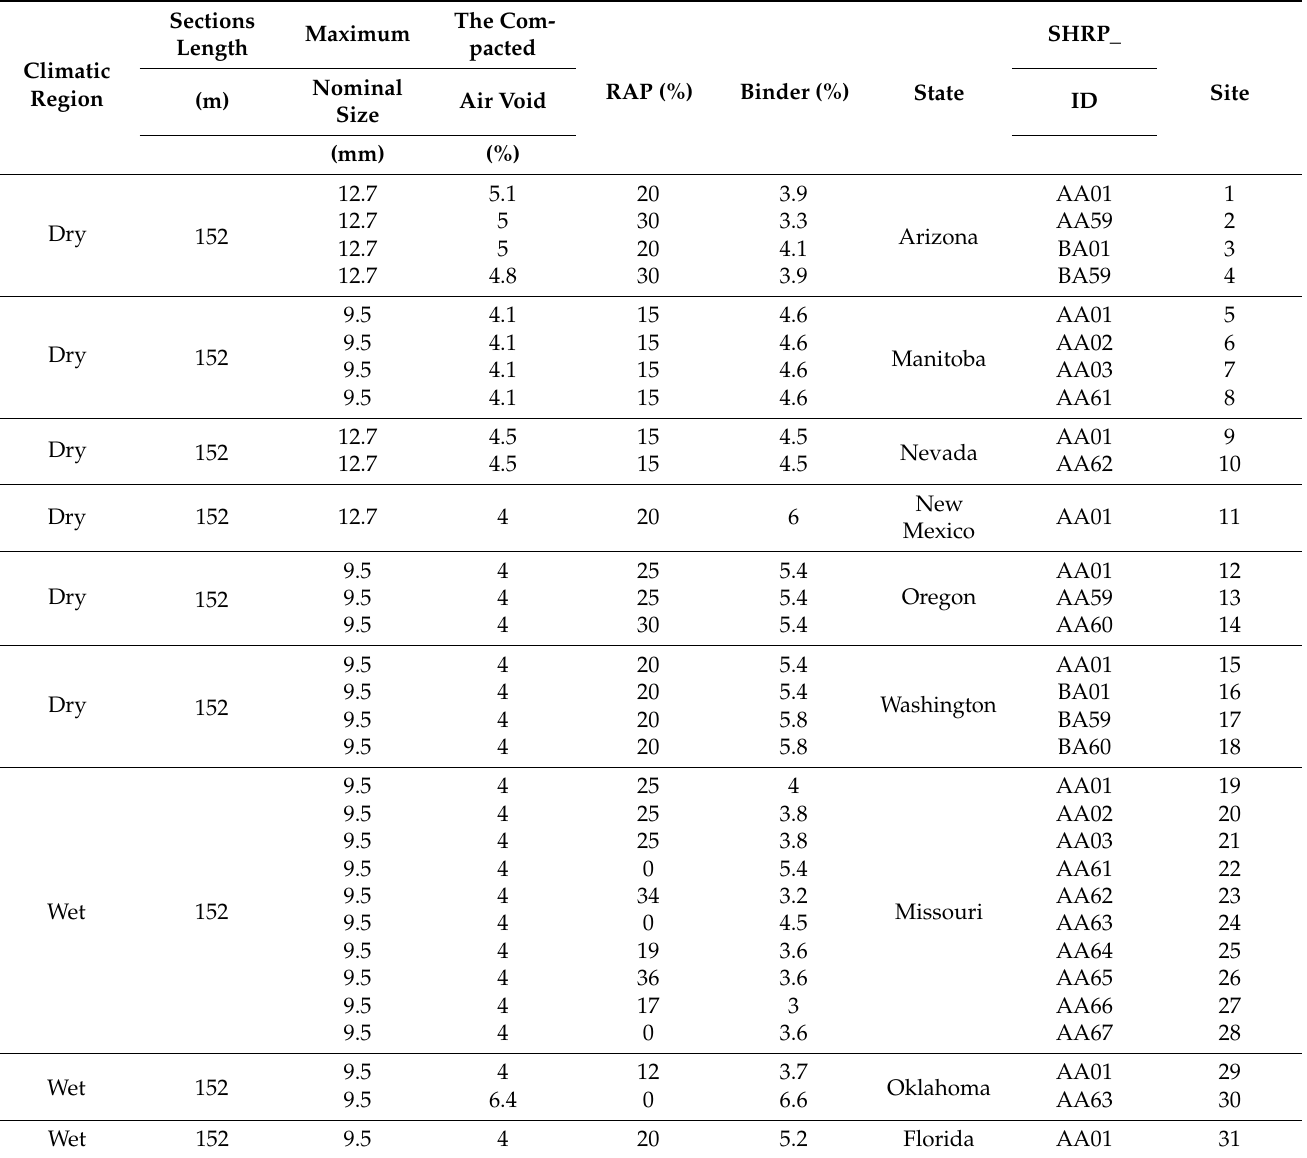
Table 1. Properties of pavement sections of